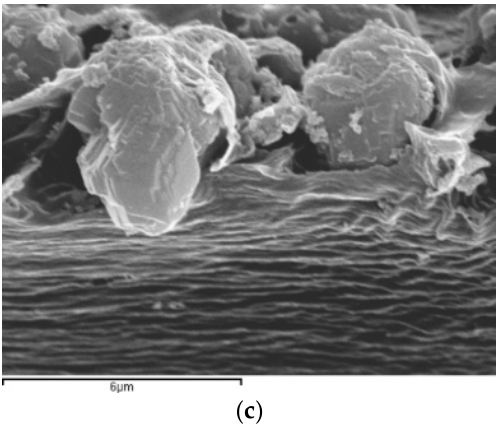
Figure 1. Scanning electron microscope (SEM) images of the detailed contact between LTA ( a ); CHA ( b ); RHO ( c ) and poly(trimethylsilyl-1-propyne) (PTMSP) in 5 wt % loaded mixed matrix membranes (MMMs). Bars correspond to 6 µm.